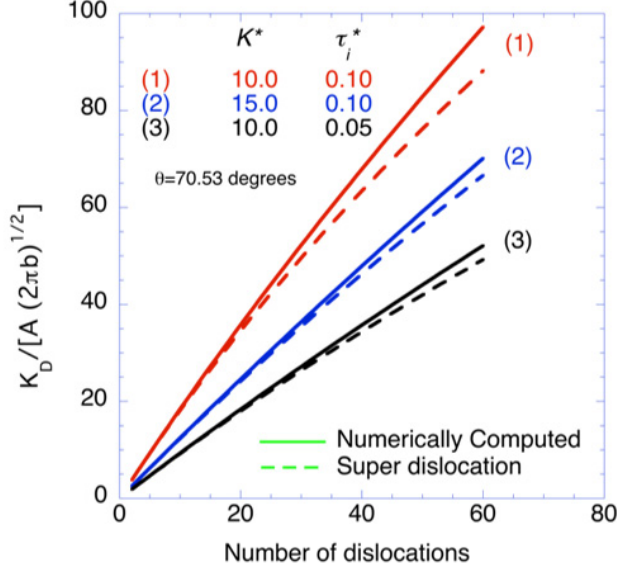
Figure 7. K D as a function of number of dislocations. Note that the increase of K ∗ reduces the effect of shielding. The decrease of the friction stress lowers the K D